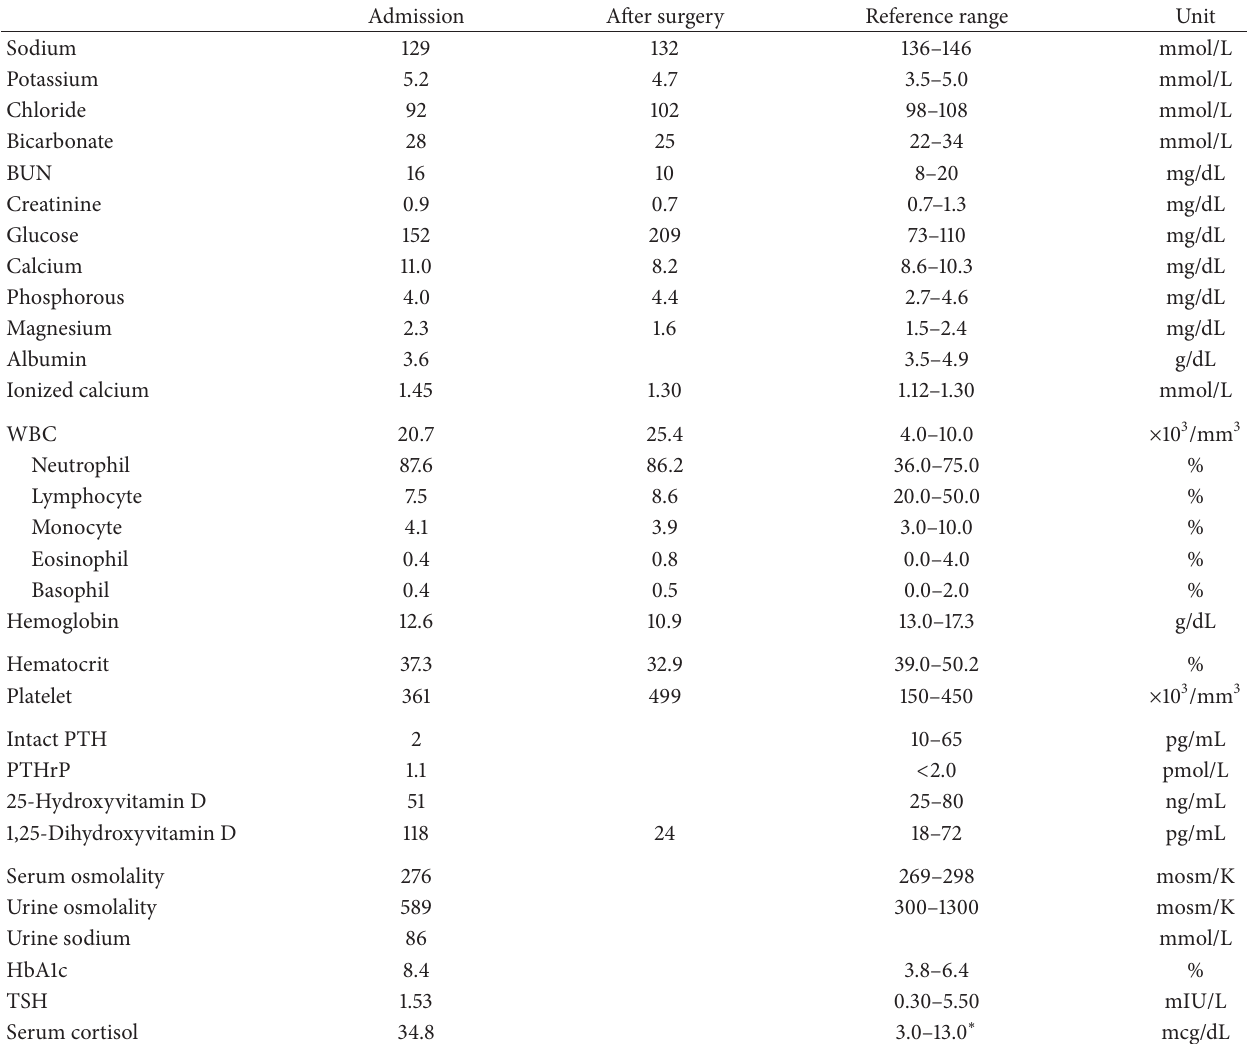
Table 1: Clinical laboratory